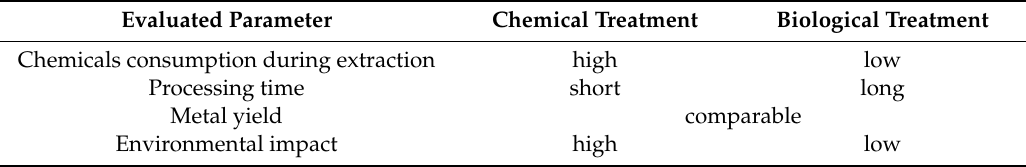
Table 4. Comparison of chemical and biological treatment of metallurgical